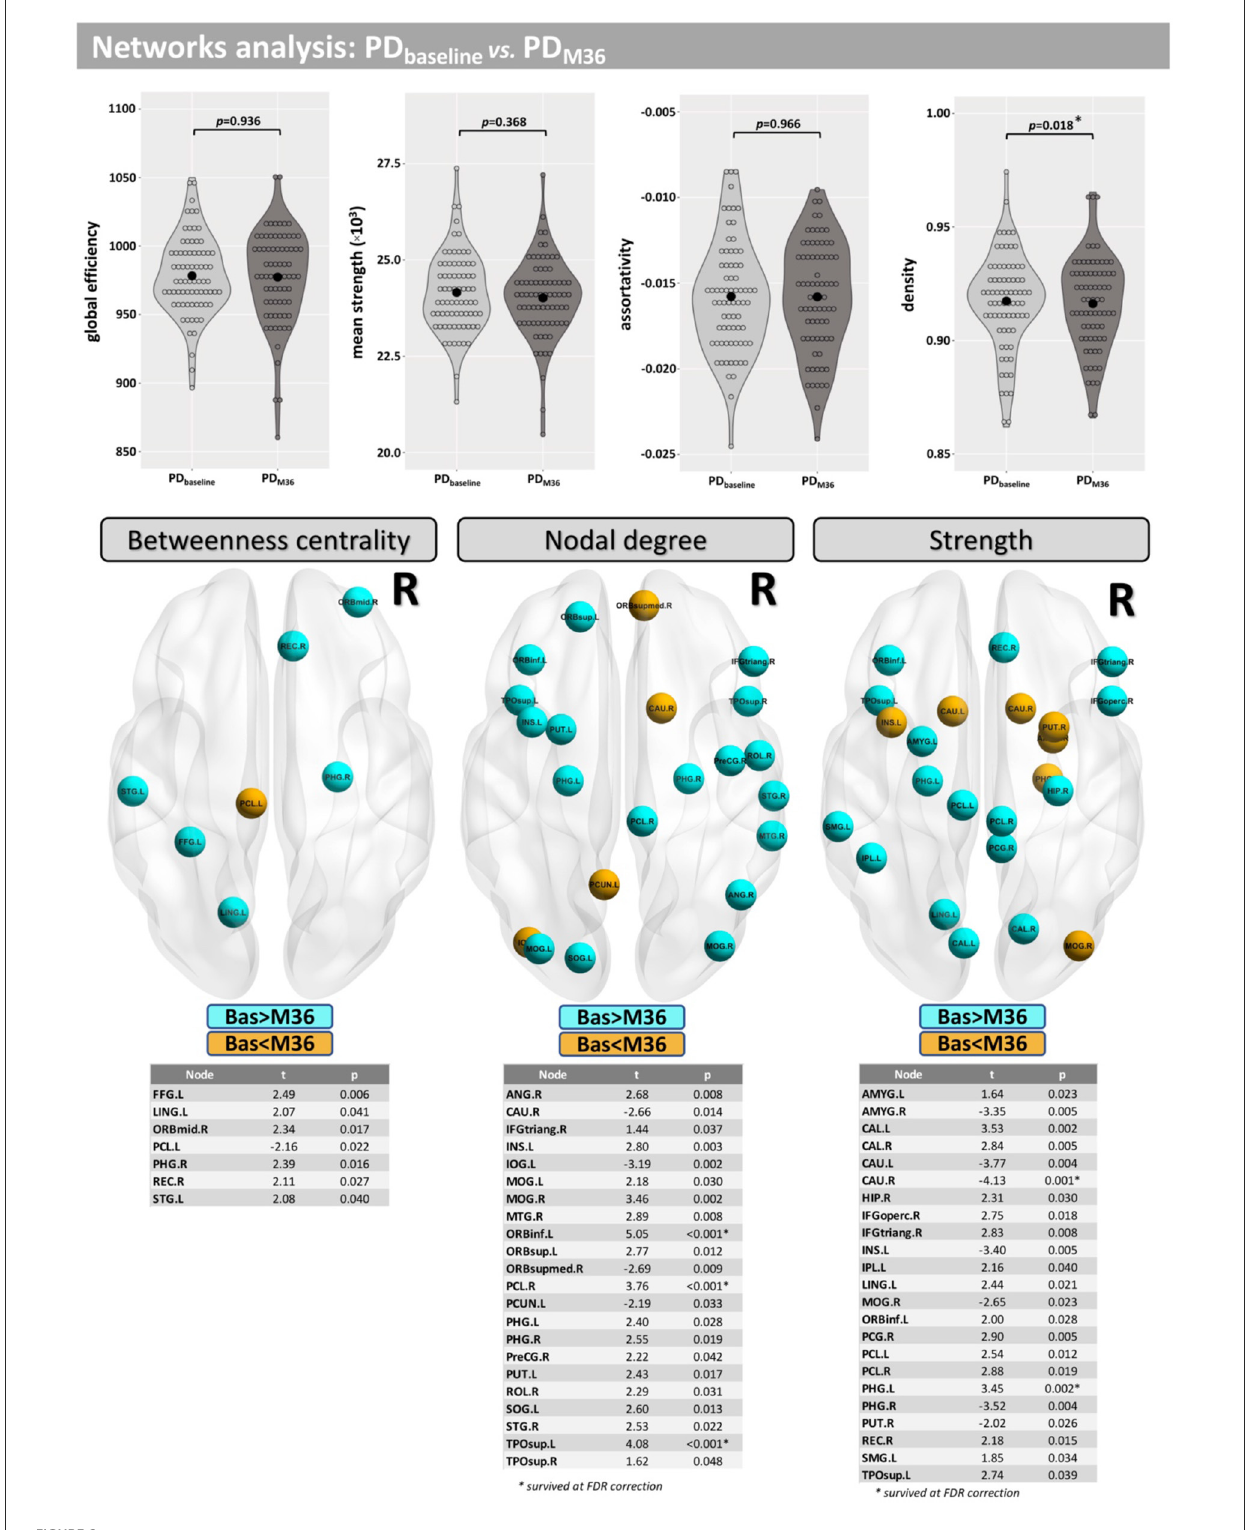
FIGURE6 Network analysis for the longitudinal part of this study. Differences between baseline and M36 were found for the network density and in several nodes for “betweenness centrality,” “nodal degree,” and